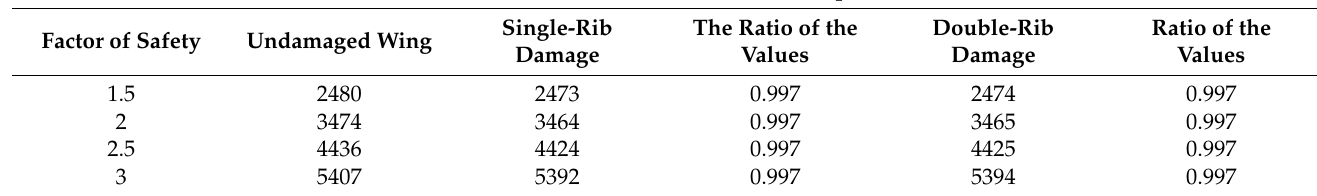
Table 18. Comparison of out-of-plane displacement in the undamaged wing and wing containing rib damage.